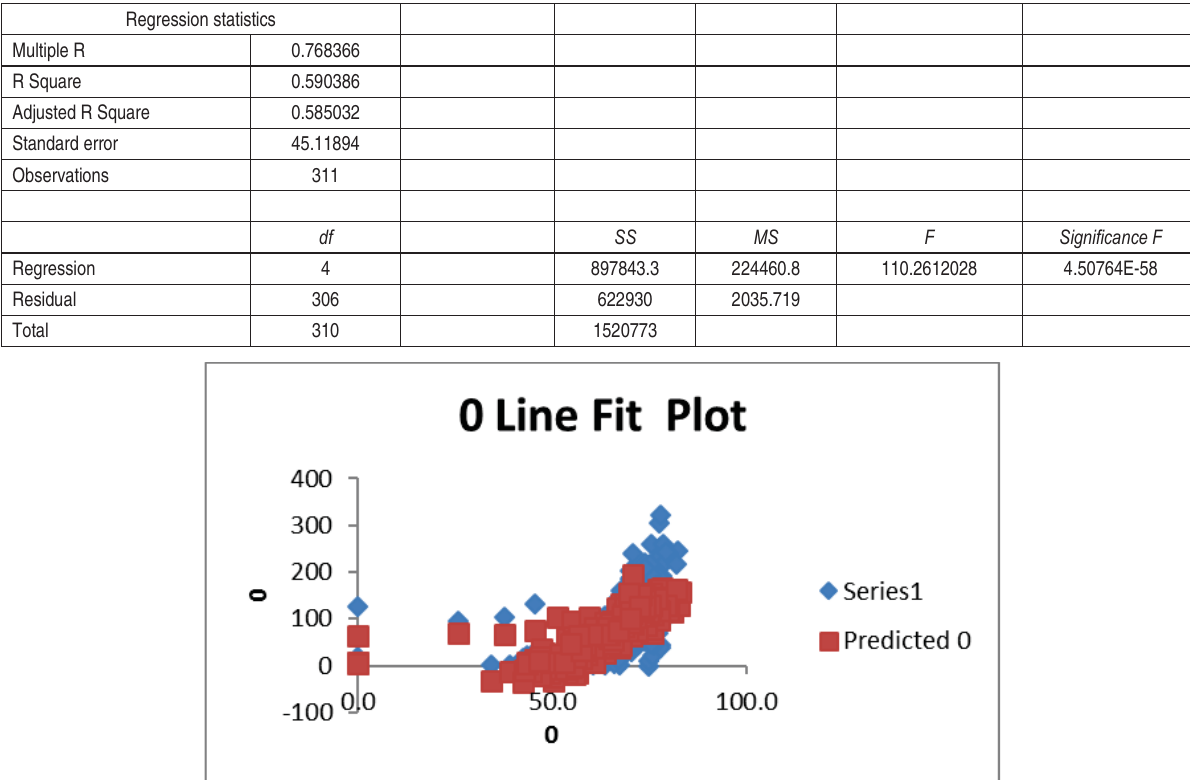
Fig. 7. The correlated best line plot